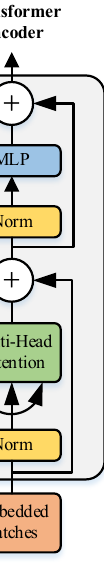
Figure 5. Transformer Encoder Module. (Reprinted with permission from Ref. [33]. 2021, Alesey Dosovitskiy, Lucas Beyer, Alexander Kolesnikov, Dirk Weissenborn, Xiaohua Zhai, Thomas Un- Neil Houlsby.)